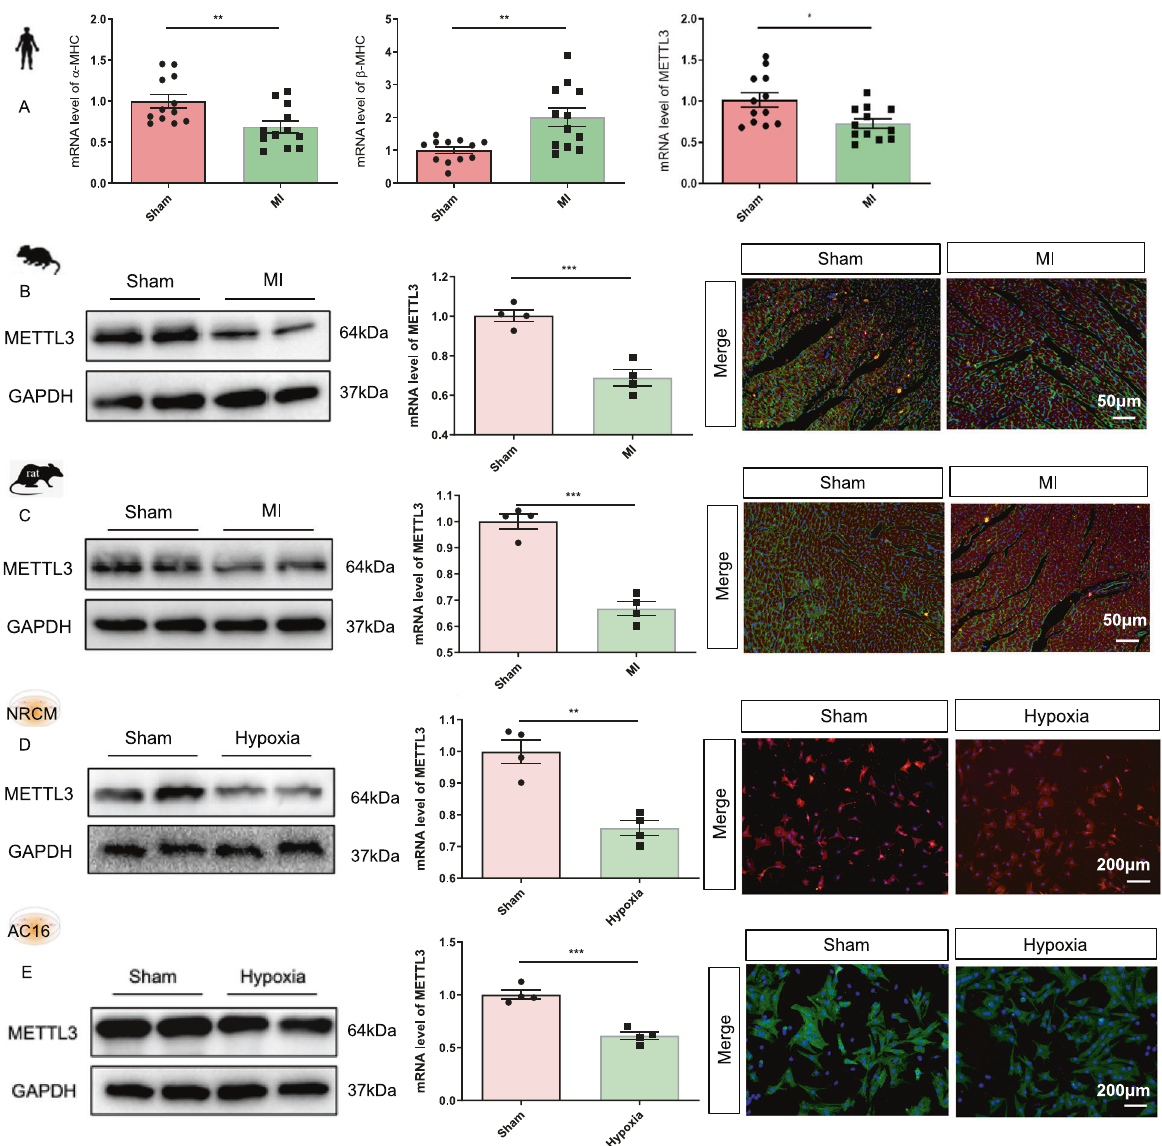
Fig. 1 Expression of METTL3 in different pathological models. A mRNA expression of α -MHC, β -MHC, and METTL3 in heart tissues from four normal cases or four patients with myocardial infarction (MI) ( n = 12). We extracted tissues from three different regions of each specimen and each tissue was included as a separate individual in the fi nal analysis. B – E Protein level, mRNA expression, and immuno fl uorescence intensity of METTL3 in the heart tissues of mice ( B ) and rats ( C ) with/without 1-week MI treatment, or in the NRCMs ( D ) and AC16 ( E ) with/without hypoxia treatment, n = 4. The data were presented as the mean ±